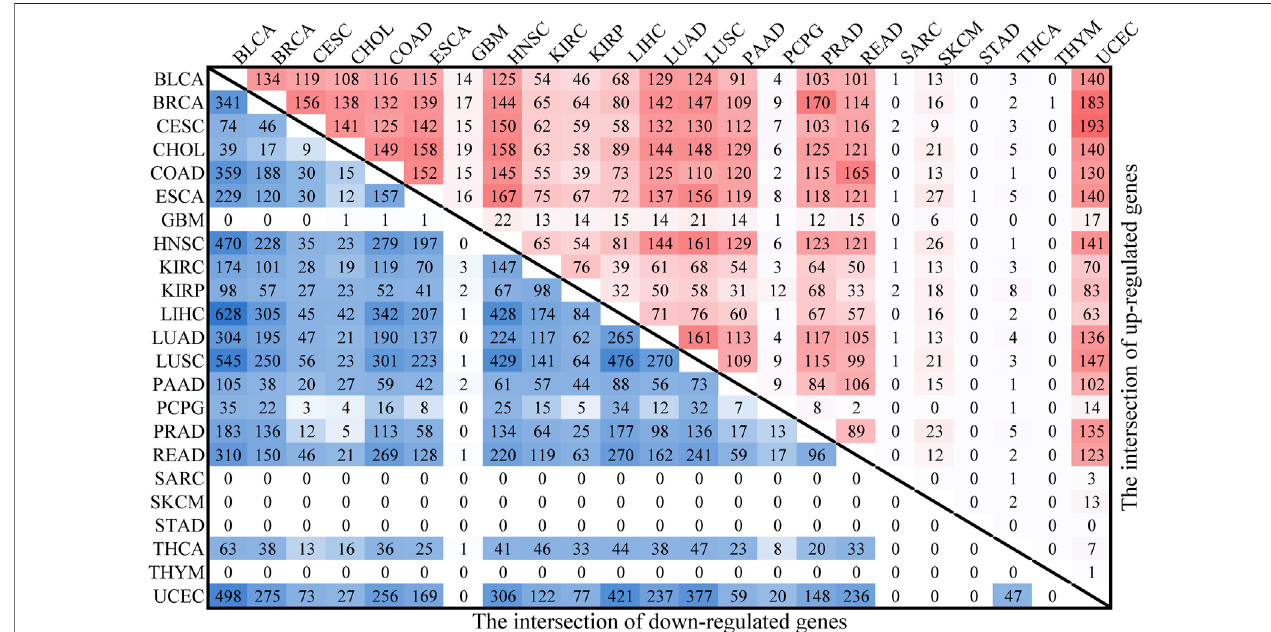
FIGURE 7 | The intersection of DMlncs for cancers. The upper red triangle represents the intersection of up-methylated lncRNAs, while the lower blue triangle represents the intersection of down-methylated lncRNAs.